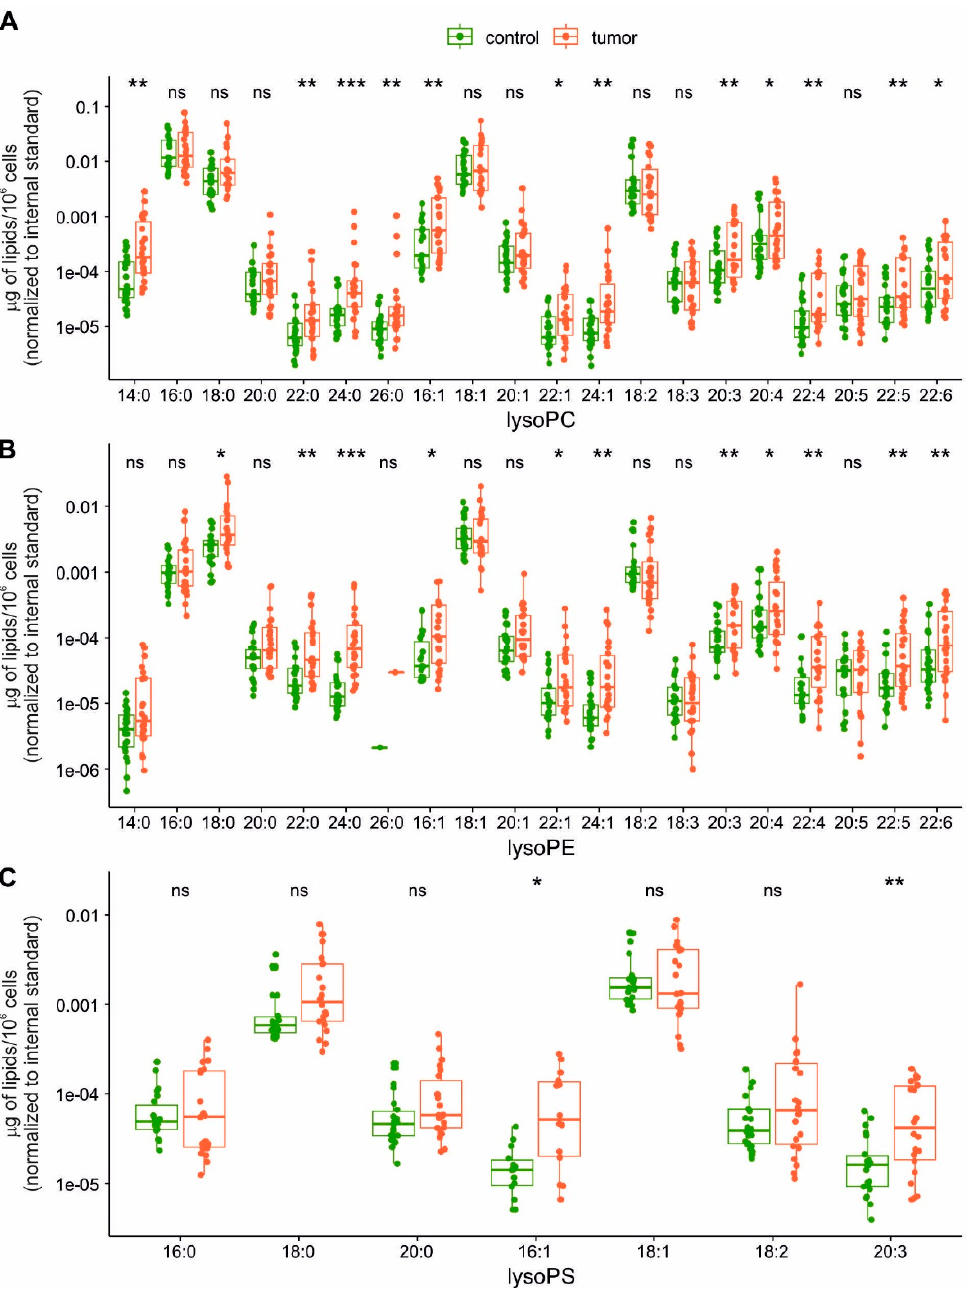
Figure 5. Comparison of the amount ( μ g of lipid/10 6 cells) of individual lysophospholipid species (indicated as number of C:double bond number). ( A ) lysophosphatidylcholine (lysoPC), ( B ) lyso- phosphatidylethanolamine (lysoPE), and ( C ) lysophosphatidylserine (lysoPS) species detected in non-tumor (control) and tumor EpCAM + cells (n = 22). Statistical significance is indicated above each box plot pair: * < 0.01, ** < 0.001, *** < 0.0001, ns ≥ 0.01. We found that significantly increased lysoPL species in tumor cells included partic- ularly FAs with longer carbon chains (C20-26). These included mostly PUFAs: C20:3n6 (dihomo- γ -linolenic acid) C20:4 (n-6 arachidonic acid or n-3 eicosatetraenoic acid), C22:4n6 (adrenic acid), C22:5n3 (docosapentaenoic acid), and C22:6n3 (docosahexaenoic